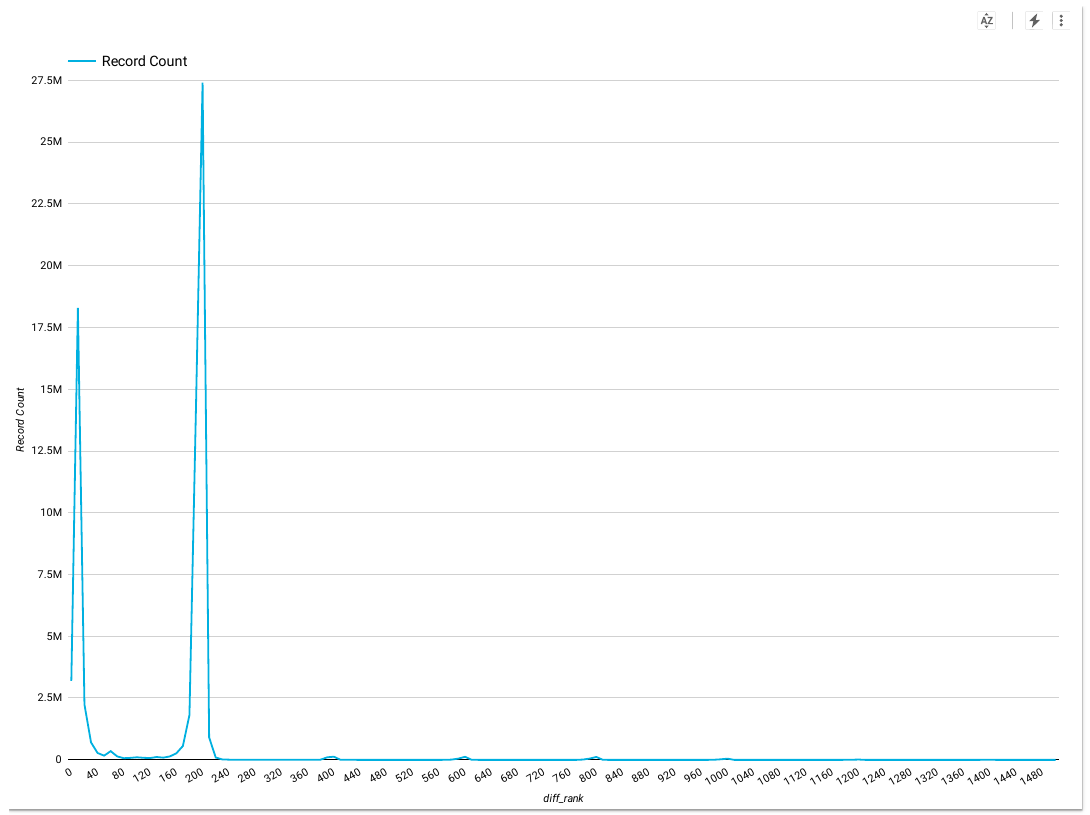
Figure 14. Demonstration of samples analysis from a real-life nursing care data ( x -axis is the timestamp difference for number of samples received in millisecond vs. record